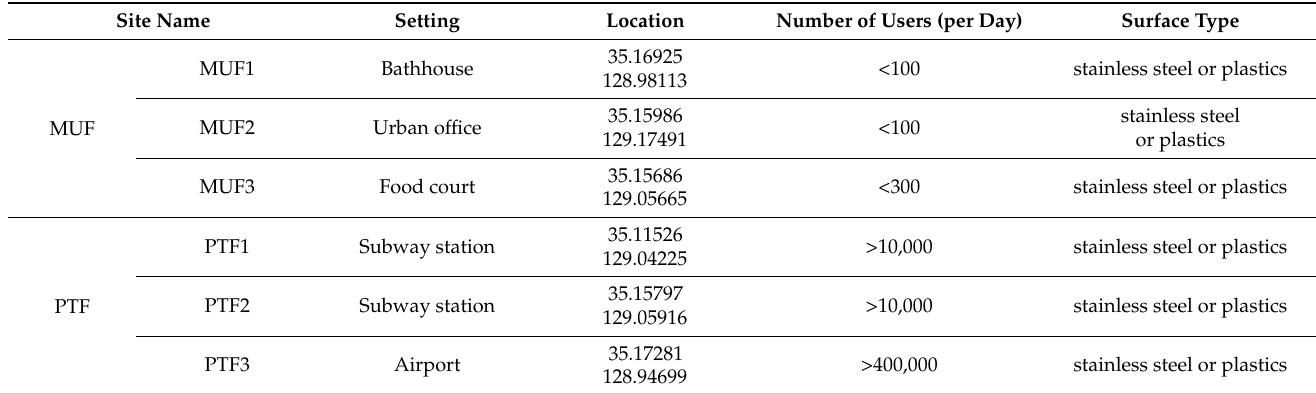
Table 1. Characteristics of the sampling